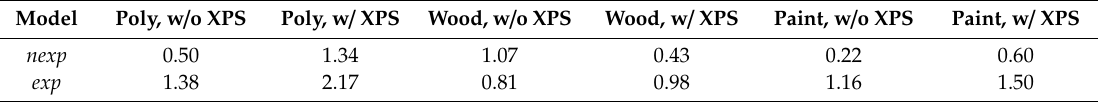
Table 5. RMSE (% MC) for near-exponential and pure exponential Q mrd models with only τ mrd allowed to